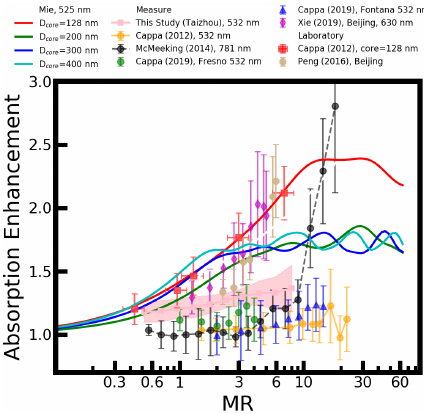
Figure 1. The measured E abs of BC particles from different ambi- ent measurements, including this work (in pink) and lab